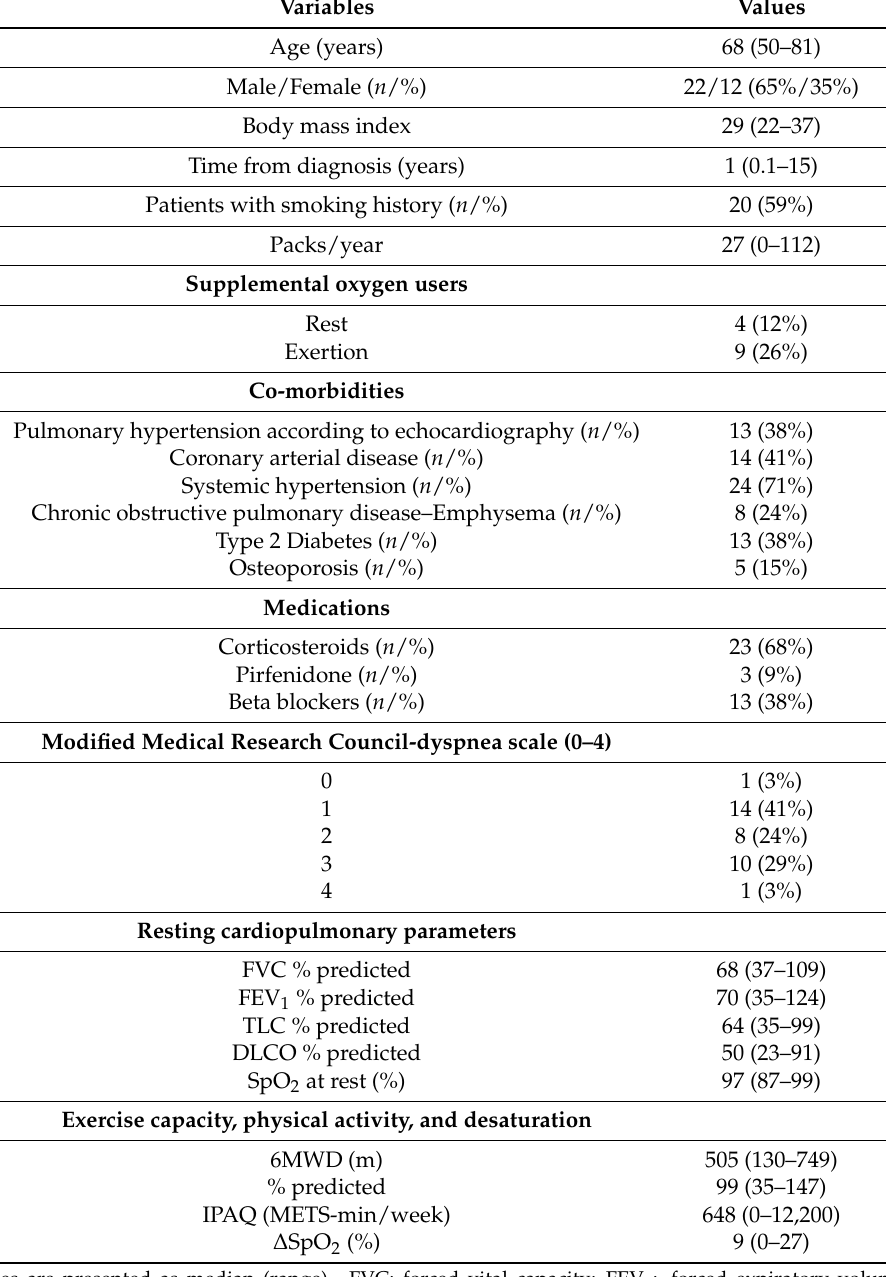
Table 1. Baseline Demographic Characteristics and Variables of Study Population ( n =